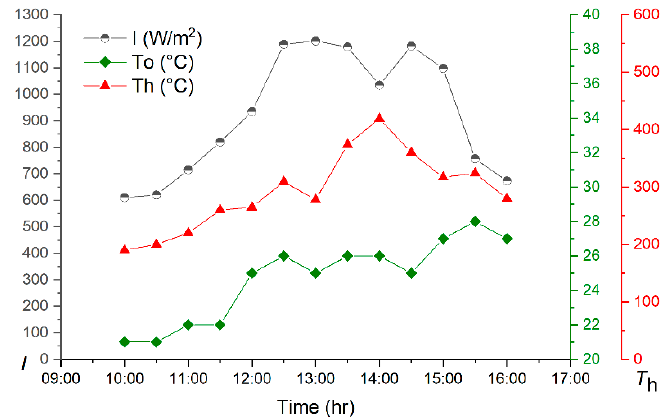
Figure 6. Radiation and temperature values measured in the solar concentrator during a typical day in Mexico City.